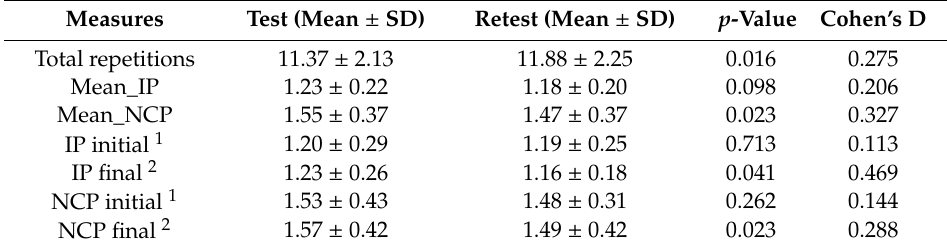
Table 2. T-test between test and retest.